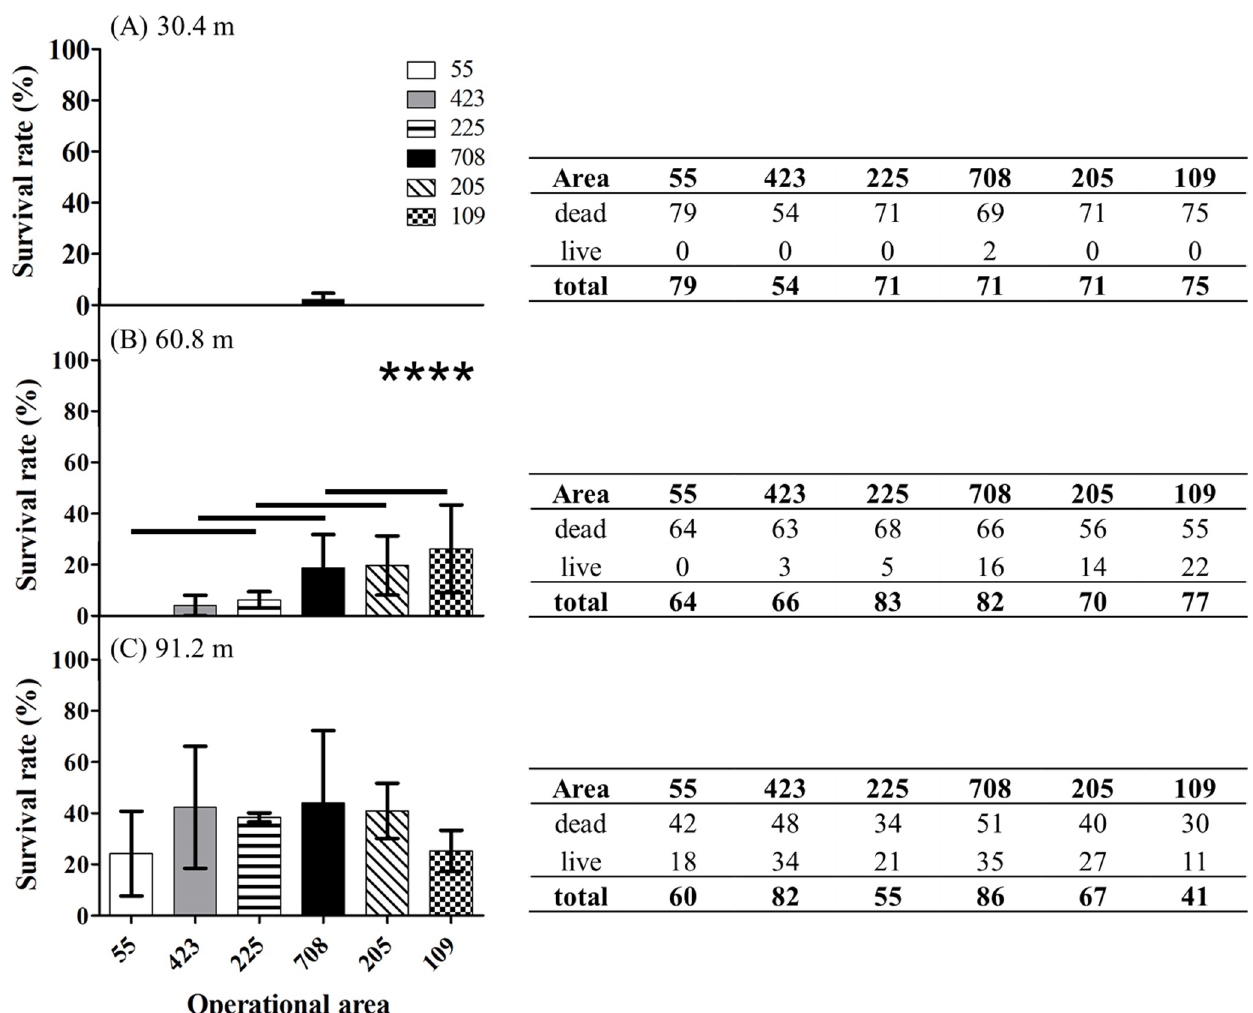
Fig 7. Survival rate of Cx . quinquefasciatus in the Permanone 1 field cage tests from six areas. (A) Permanone 1 31–66 was applied at 30.4 m from cages; (B) at 60.8 m; or (C) at 91.2 m. The tables on the right present for each distance the number of dead and alive mosquitoes from each area, after field cage tests; these numbers were used for the histograms on the left. The Chi-square test was only significant for the survival rates at 60.8 m with P < 0.0001. Therefore, the analyses were followed by pairwise comparison tests to detect significant differences. Horizontal lines above bars indicate the areas which are not significantly different ( P < 0.05). For each area, histograms show Mean ± SEM.